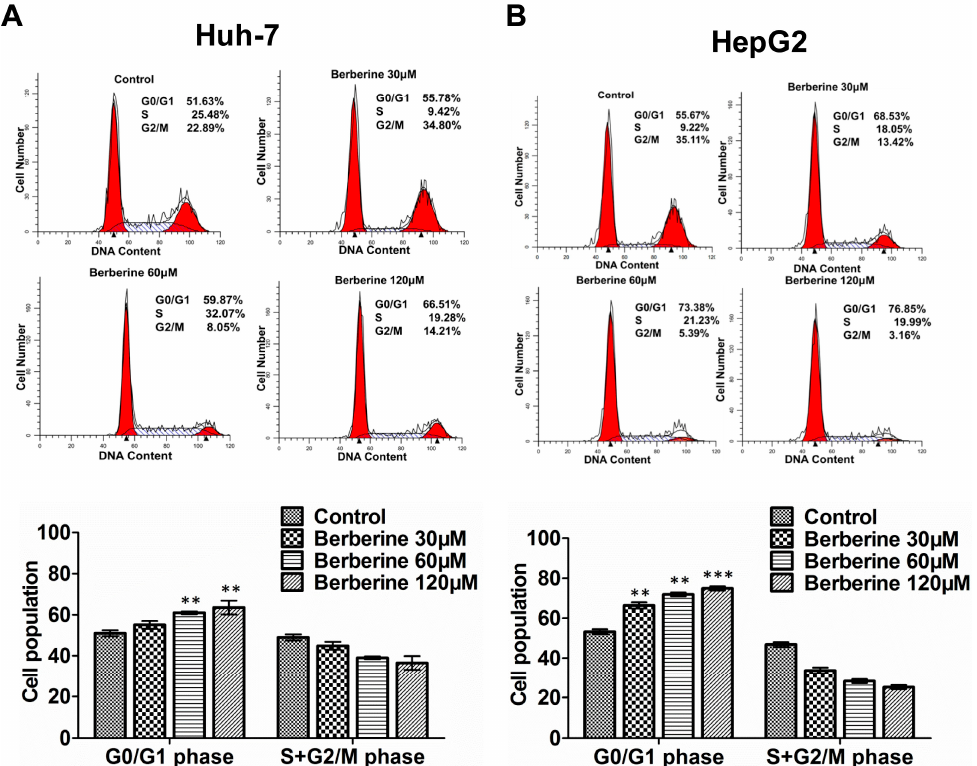
Figure 2. Berberine induces G0/G1 cell cycle arrest in a dose-dependent manner in Huh-7 ( A ) and HepG2 ( B ) cells. Cells were treated with DMSO (control) or berberine (30–120 μ M) for 24 h before staining with PI and analyzed by flow cytometer analysis. Distributions of cell cycle are shown in the following bar graph. *** represents p < 0.001, and ** represents p < 0.01 (60, 120 μ M vs. control group). The experiments were carried out for three times.